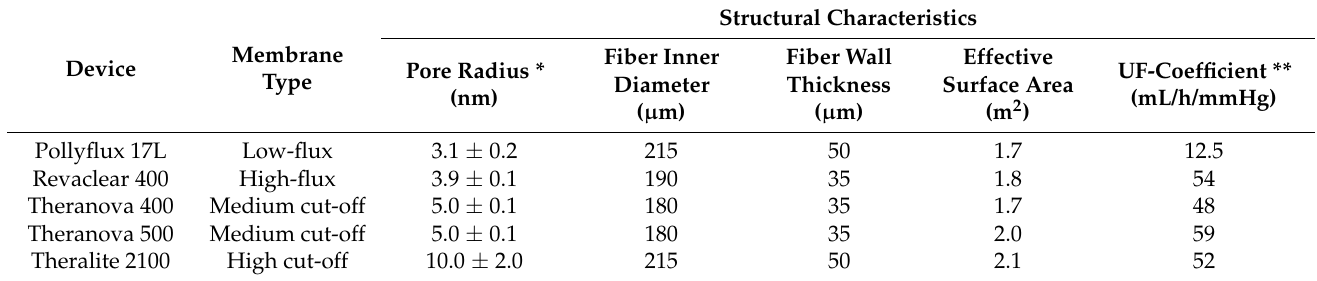
Table 2. Comparison of four dialyzer types in parameter characteristics. Information is from instruc- tions of Baxter International, Inc., Deerfield, IL, USA.